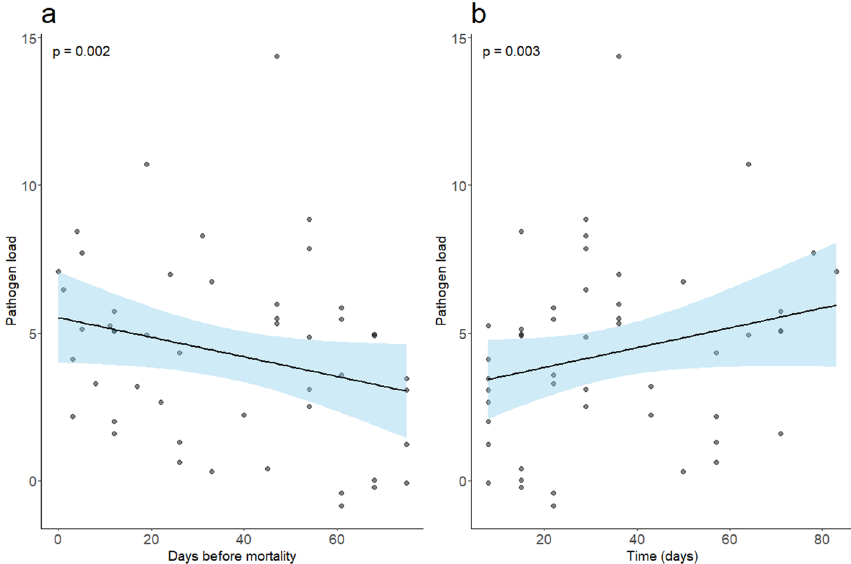
Figure 1. Days before mortality and time are predictive of pathogen load in inoculated snakes. ( a ) Pathogen load is represented as a function of time measured in units of days before mortality. Pathogen load values were derived from the natural log transformation of copy number values for O. ophidiicola . The negative trendline in this subplot indicates that as snakes were temporally closer to mortality, we observed higher pathogen loads. ( b ) The positive trendline in this subplot indicates that as the experiment progressed, we observed higher pathogen loads. LME model p -values for temporal effects are provided within each